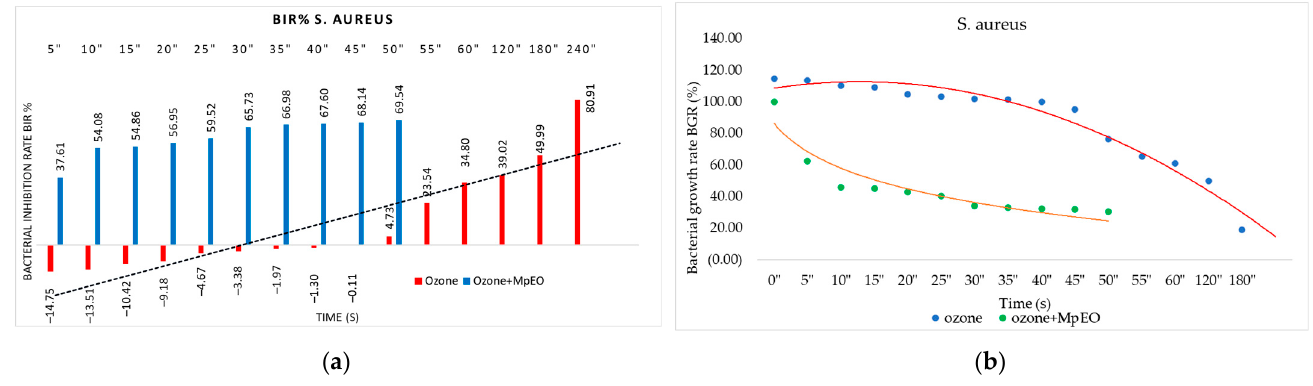
Figure 2. Ozone and ozone+MpEO antimicrobial activity on S. mutans at different time exposures expressed in seconds ( ″ ). ( a ) Results expressed as BIR%; ( b ) results expressed as BGR%.